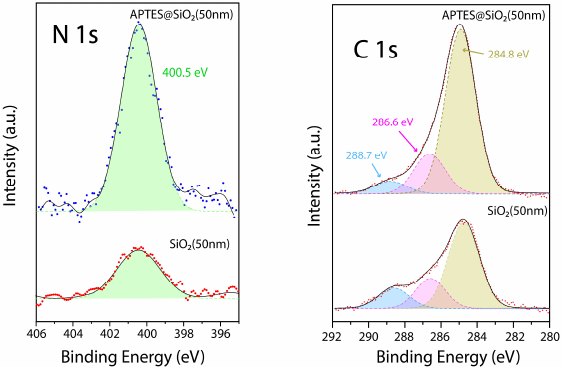
Figure 4. XPS spectra of the ( left ) N 1s region and ( right ) C 1s for the SiO 2 (50 nm) and APTES@SiO 2 (50 nm) samples.